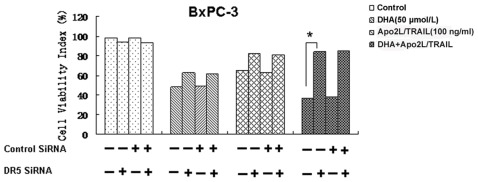
Effects of knockdown of DR5 expression on DHA-induced cytotoxicity and cell apoptosis of Apo2L/TRAIL.BxPC-3 and PANC-1 cells were transfected with DR5 siRNA and control siRNA, either alone or in combination. After 48 h, the cells were treated with 50 µmol/L DHA for 24 h, and whole cell extracts were subjected to western blotting to test for the expression of DR5. Transfection of cells with siRNA targeting DR5 specifically silenced the expression of DR5. The cells were seeded on a chamber slide and transfected with siRNAs. After 48 h, the cells were treated with 50 µmol/L DHA, 100 ng/mL Apo2L/TRAIL, either alone or in combination, and incubated at 37°C for 72 h. The viability of the cells was assessed using the MTT method, and the viability index (%) was calculated. Silencing of DR5 by siRNA reduced the cytotoxic effect of the combination of DHA and Apo2L/TRAIL but not of DHA alone. Significant differences are denoted by “*” (P<0.01).